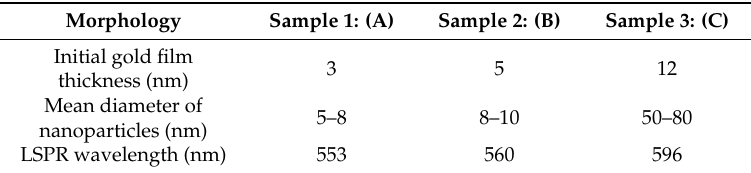
Table 1. Statistical information of annealed gold nanoparticles about their morphology and LSPR position over three independent prepared three glass nanostructured samples.